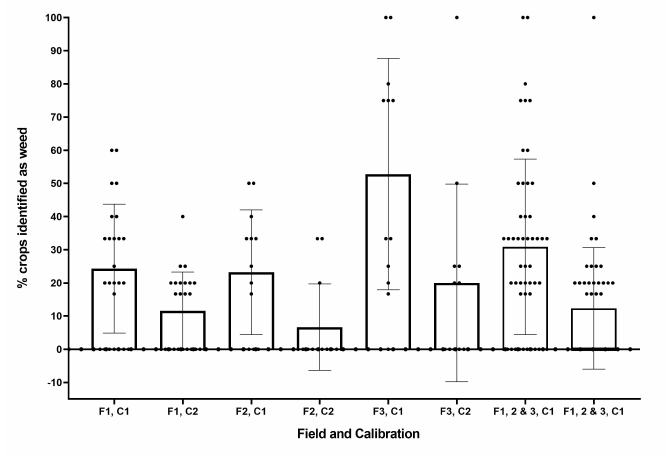
Figure 14. Percentage of crops misidentified for each field (F1-3) and calibration (C1,